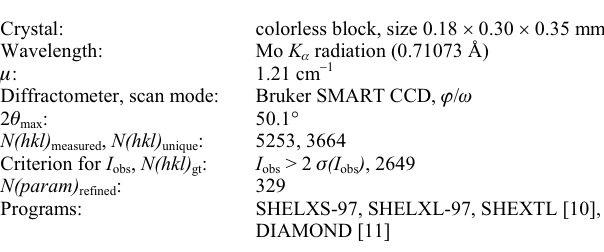
Table 1. Data collection and handling.